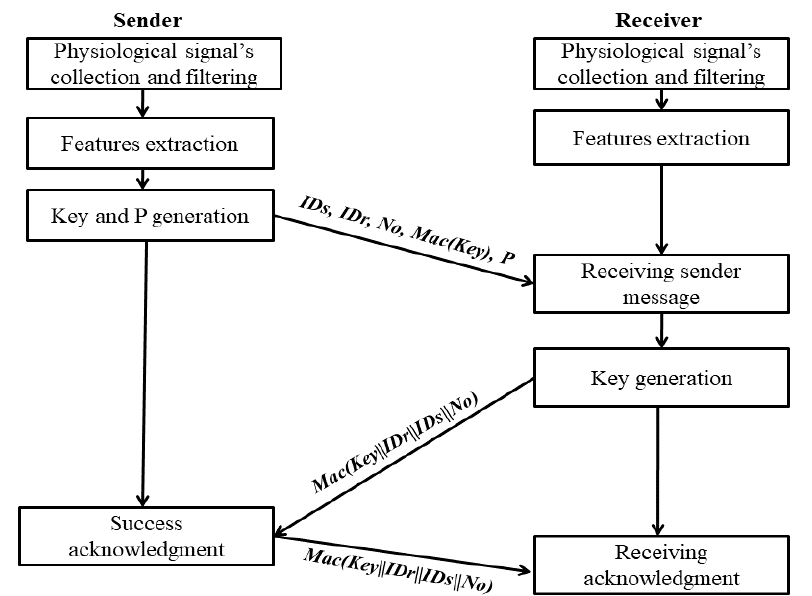
Figure 3. The first connection’s cycle flowchart.